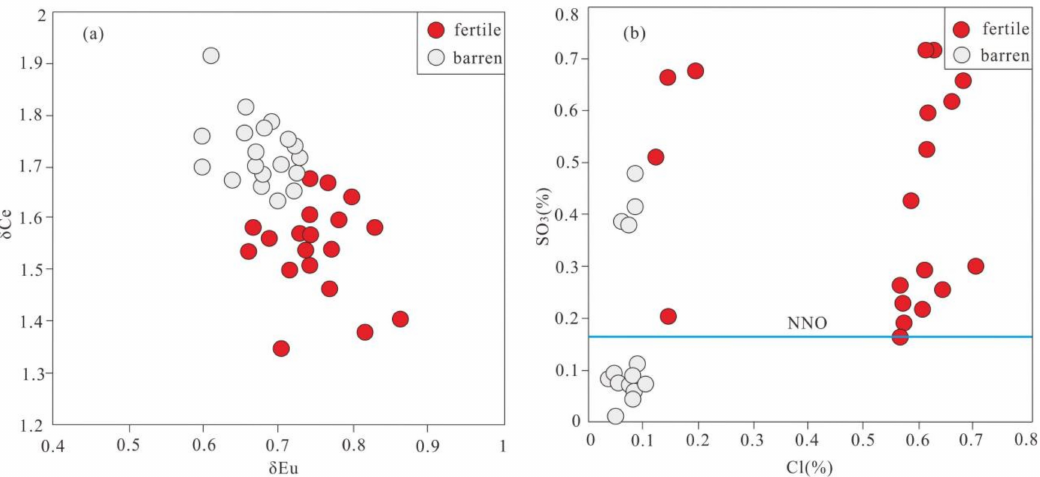
Figure 10. ( a ) Plots of δ Eu vs. δ Ce in apatite; ( b ) Plots of SO 3 vs. Cl contents (%) in apatite. The nickle-nickle oxide buffer (NNO) line is from